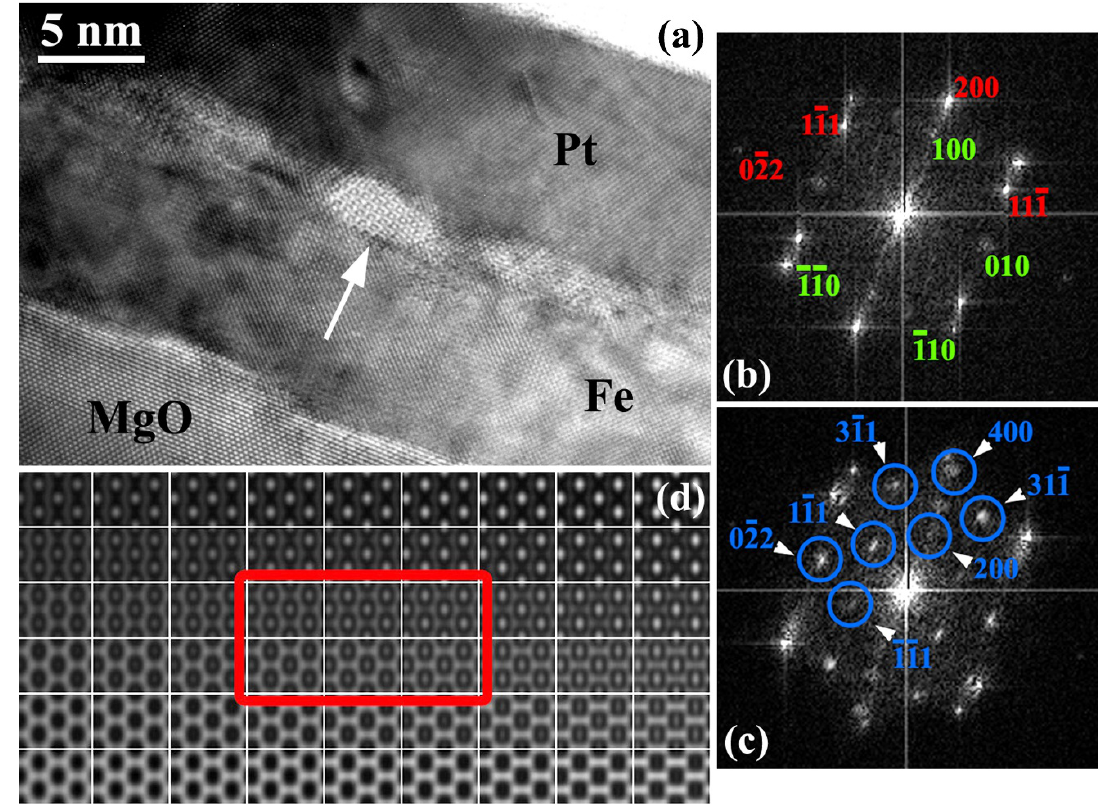
Figure 2. ( a ) HRTEM image of the Fe/Pt interface, along the [011]MgO/[001]Fe/[011]Pt projection direction, comprising three pits. Two of them are filled with Pt, while the third one (white arrow) is filled with ferrimagnetic Fe 3 O 4 . ( b ) Common FFT diffractogram of MgO (red indices) and Fe (green indices). ( c ) Common FFT diffractogram of Fe/Pt along with the central pit. The spatial frequencies denoted by blue circles and their symmetric relative to the central spot belong to the [011] zone axis of Fe 3 O 4 (magnetite). ( d ) Through-focus-thickness HRTEM image simulation map of magnetite for − 46 to 0 nm defocus values (x-axis) and sample thickness from 2.4 to 16.6 nm (y-axis). Image simulations that resemble the experimental image are included in the red rectangle.